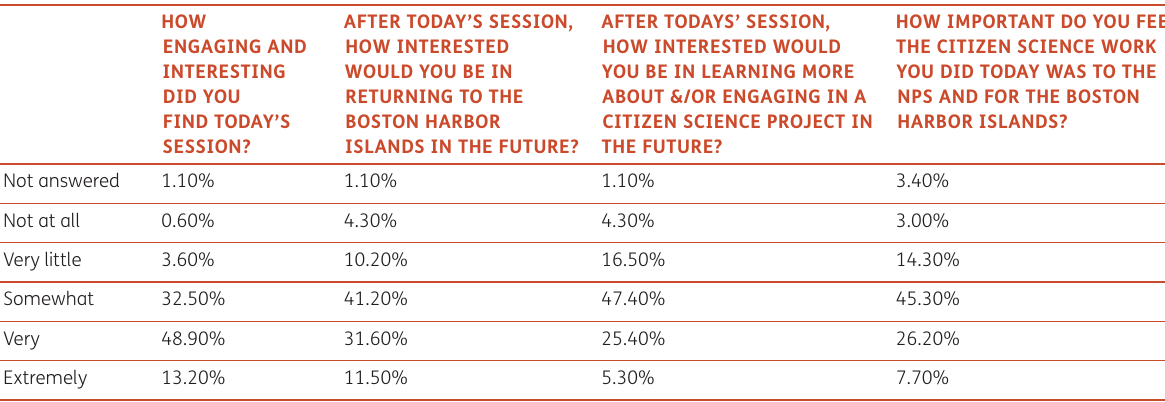
Table 2 Post-survey results: Most students were very or extremely engaged overall (first column), and somewhat or very engaged in more specific aspects of the activity (second to fourth columns). Less than 5% were very little or not at all engaged overall, and 14.5 to 20.8% were very little or not at all in more specific aspects of the activity (second to fourth columns). Note : NPS: National Park